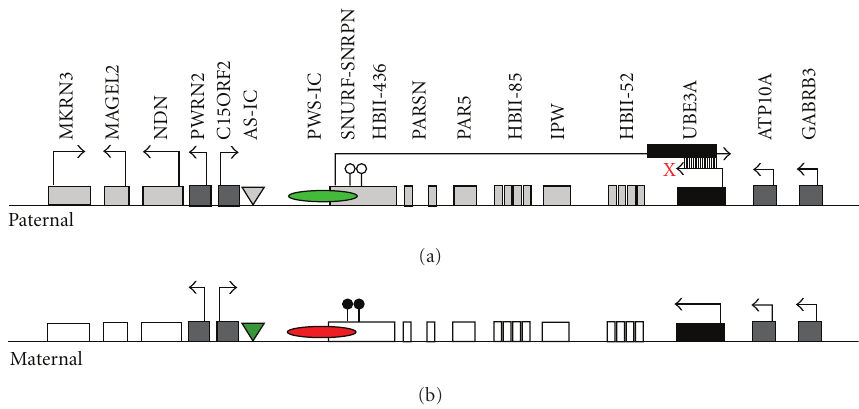
Figure 1: Imprinting map of the human chromosome 15q11-13 region around AS imprinting centre (AS-IC). Paternal and maternal chromosome 15q11-13 regions around AS-IC and PWS-IC are represented in (a) and (b), respectively. Paternally expressed genes (gray boxes), maternally expressed genes (black boxes), maternally repressed genes (white boxes), and biallelically expressed genes (dark gray boxes) are represented with arrows marking transcription start sites. Right arrow indicates gene transcription on “+” strand, whereas left arrow indicates gene transcription on “ − ” strand. AS-IC (triangle) and PWS-IC (ellipse) are shaded depending on histone modification in the area. AS-IC is dormant (gray triangle) on paternal chromosome, whereas on the maternal chromosome it is acetylated and methylated at H3-lys4 (green triangle), thus active. PWS-IC is active on paternal chromosome (green ellipse) since it is also acetylated and methylated at H3-lys4. However, PWS-IC at the maternal chromosome is methylated at H3-lys9 and repressed (red ellipse). Di ff erentially CpG methylated region (DMR1) in SNRPN exon 1 overlaps with PWS-IC partially. Note that DMR1 on maternal but not paternal chromosome is methylated (black pin). UBE3A-ATS (antisense transcript) originating upstream of SNRPN can either be a degradable complex with UBE3A transcript or prevent the extension of UBE3A transcript (collision or upstream histone modifications represented by “X”).